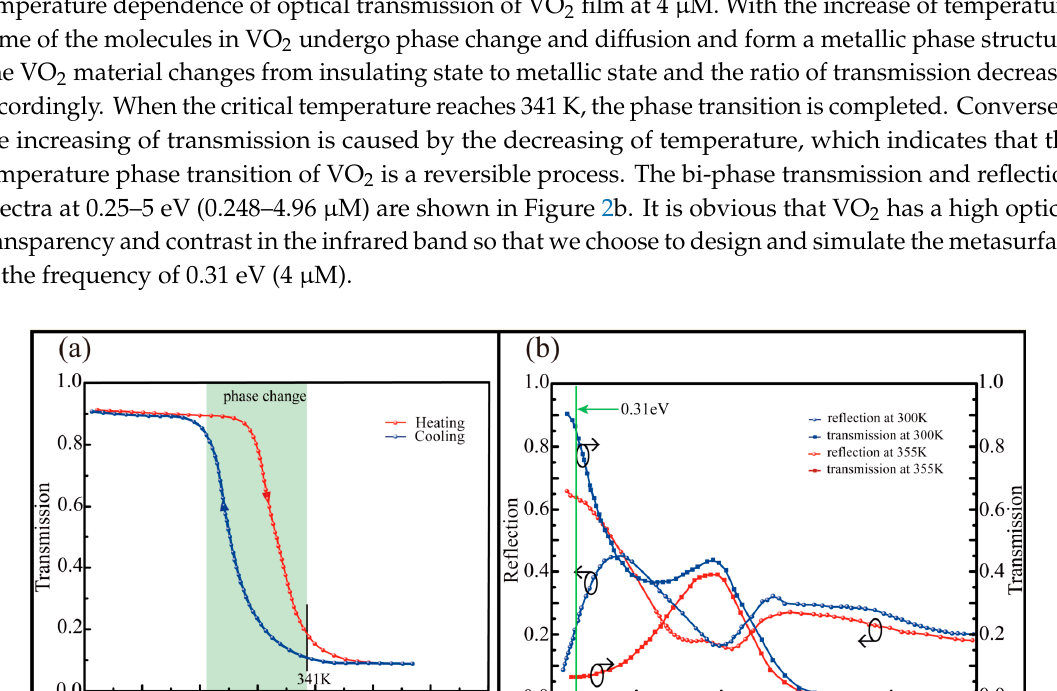
Figure 3a–c illustrate the meta-atoms of the designed metasurface. The unit size of the meta- atom is optimized by parameter sweeps, which is obtained H = 1.5 μ M, T = 1 μ M, D = 0.7 μ M. The